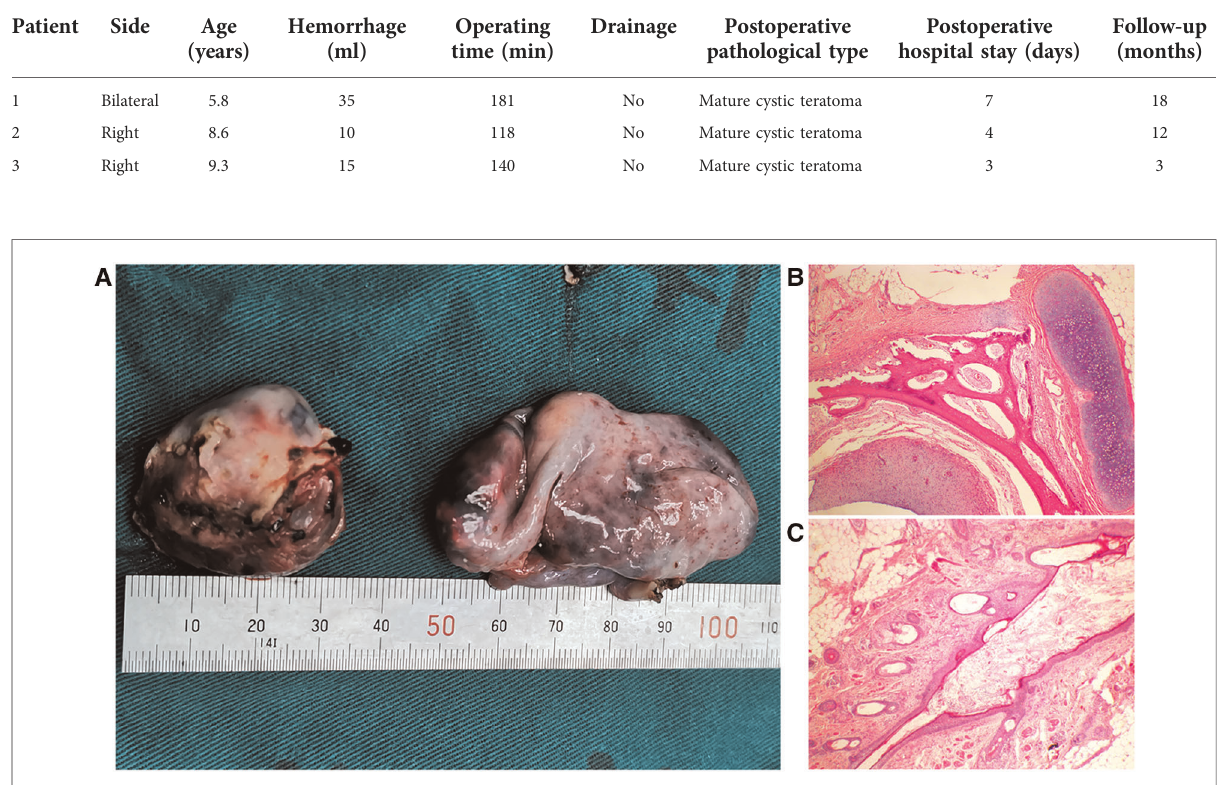
TABLE 2 Data of